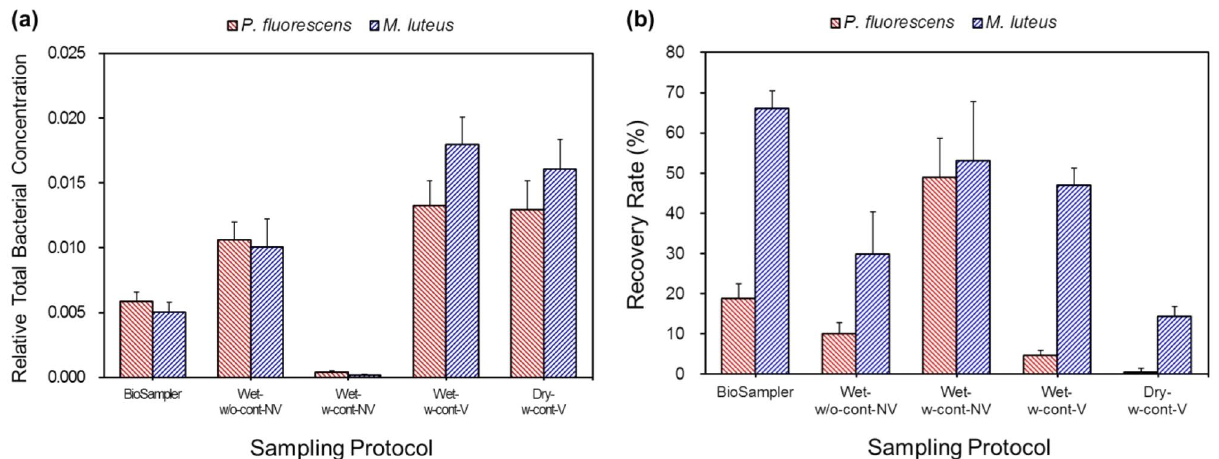
Figure 3. Relative total bacterial concentrations ( a ) and recovery rates ( b ) of P. fluorescens and M. luteus eluted into sampling media of 1 × phosphate buffered saline in the EPC (− 5 kV) and in the BioSampler. Four different sampling protocols were used in the EPC. Wet-w-cont-NV wet sampling with a container, but no vortexing after the sampling, Wet-w-cont-V wet sampling with a container and vortexing after the sampling, Wet-w/o-cont-NV wet sampling on a polyimide film of the EPC electrode with no vortexing, Dry-w-cont-V dry sampling with a container and subsequent vortexing after buffer